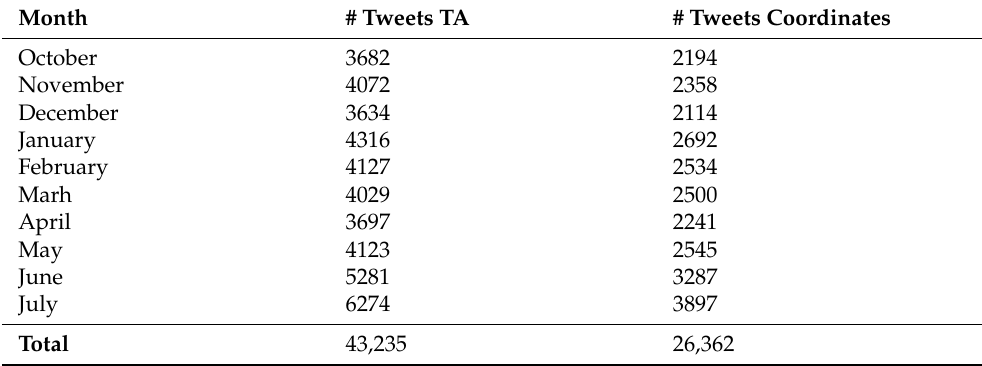
Table 15. Number of tweets related to traffic accidents with location and coordinates per